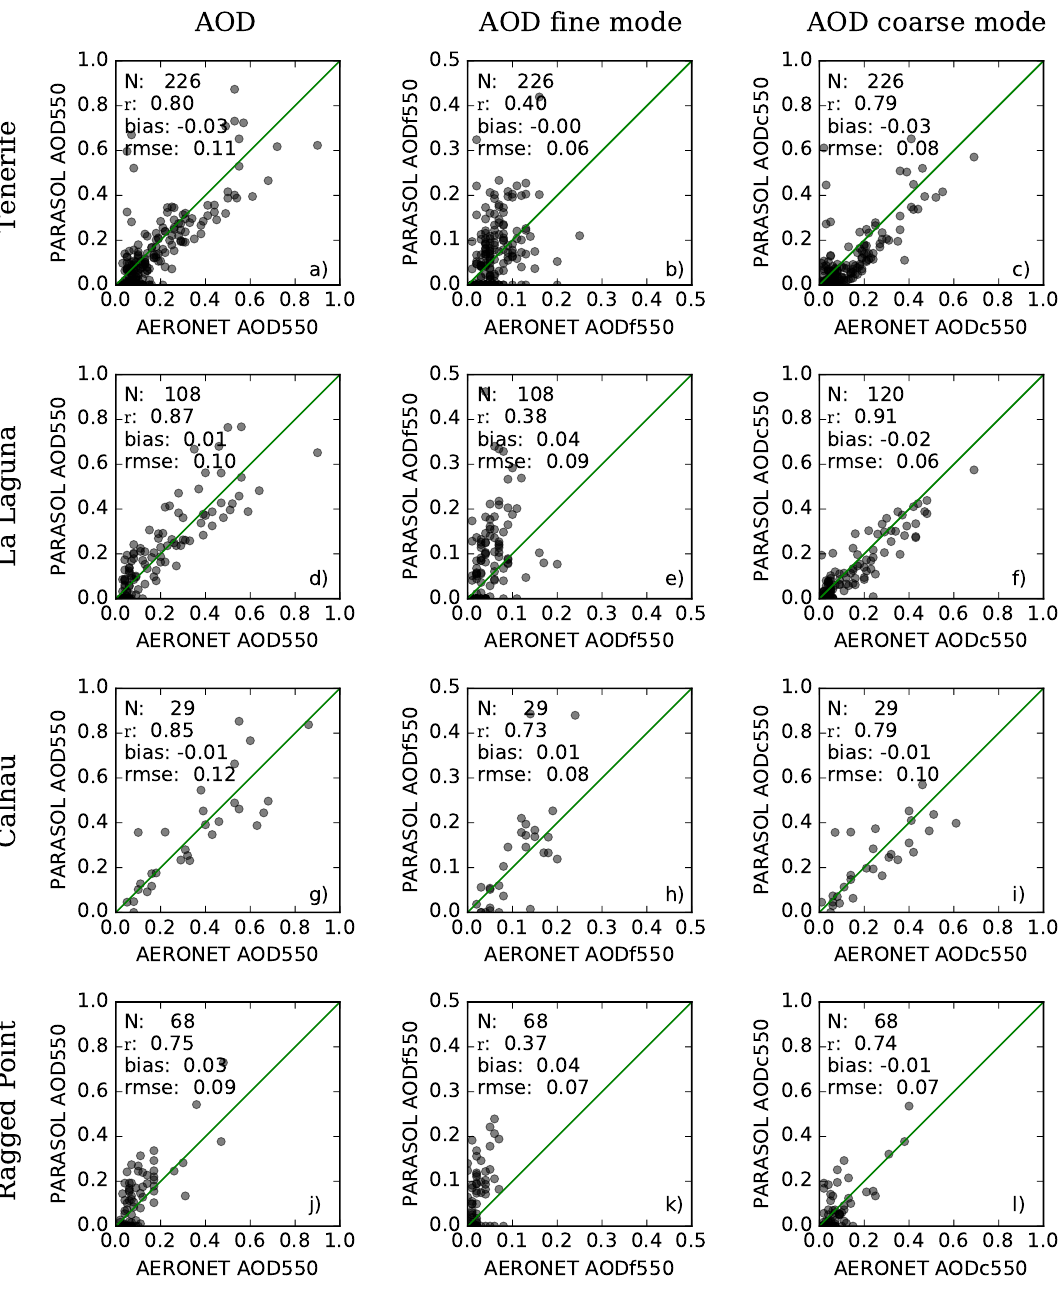
Figure 5. Left column: comparisons of PARASOL AOD and AERONET AOD at 550 nm for the period 2005–2013 at ( a ) Tenerife, ( d ) La Laguna, ( g ) Calhau and ( j ) Ragged Point. Center column: same comparisons as left column but for AOD f at ( b ) Tenerife, ( e ) La Laguna, ( h ) Calhau and ( k ) Ragged Point. Right column: same comparisons as left column but for AOD c at ( c ) Tenerife, ( f ) La Laguna, ( i ) Calhau and ( l ) Ragged